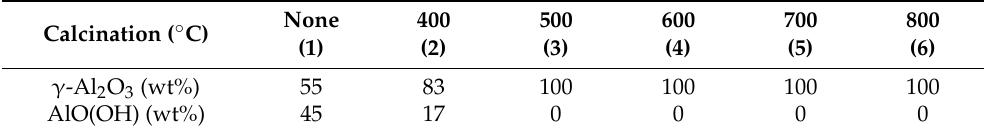
Table 3. Composition of the support after different calcination